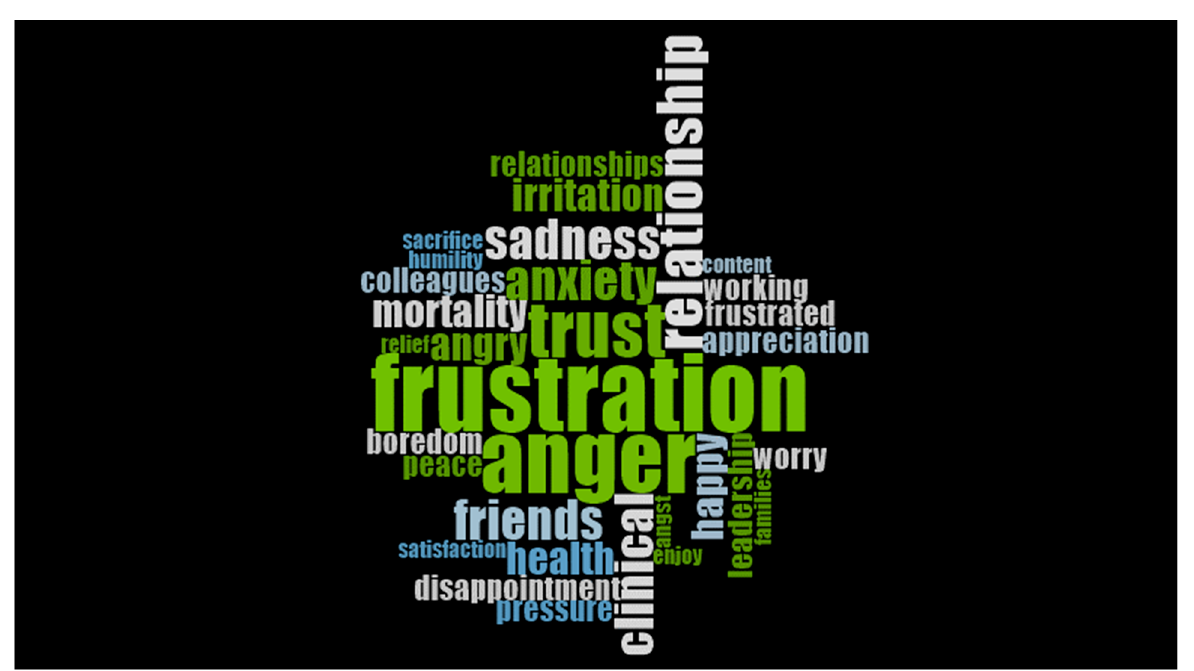
Figure 2. Word cloud depicting the most common words physicians used to express their emotions related to their pandemic experience.